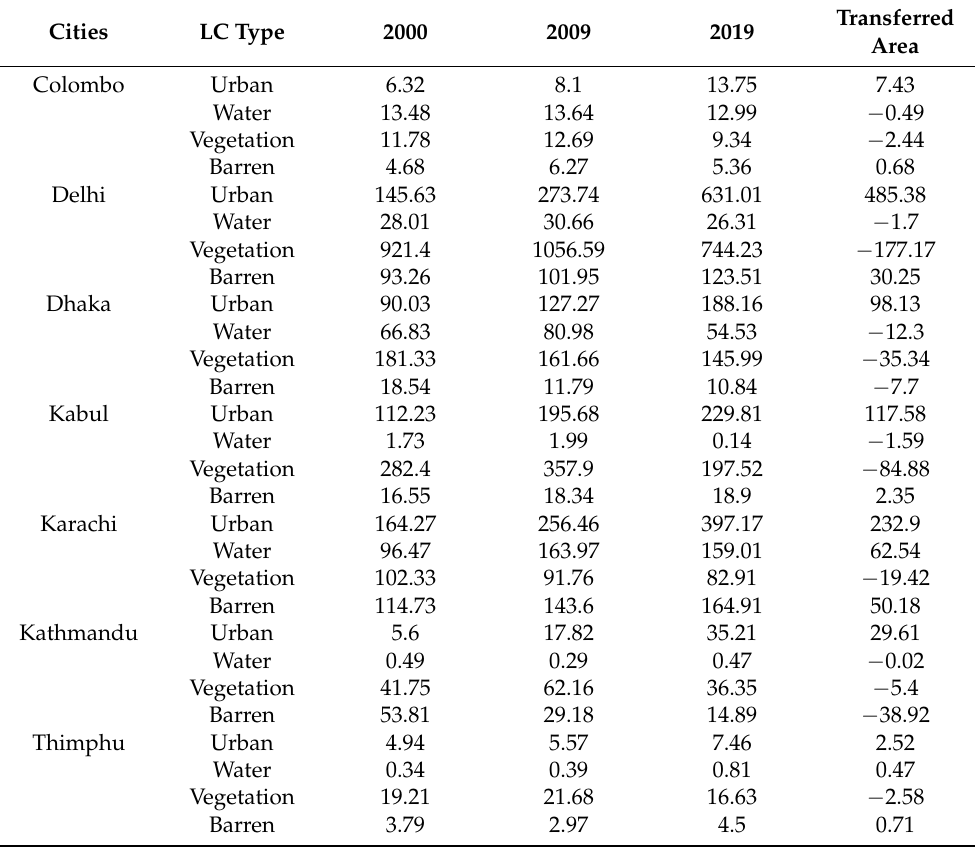
Table 4. LULC Change Matrix for SA Cities 2000, 2009 and